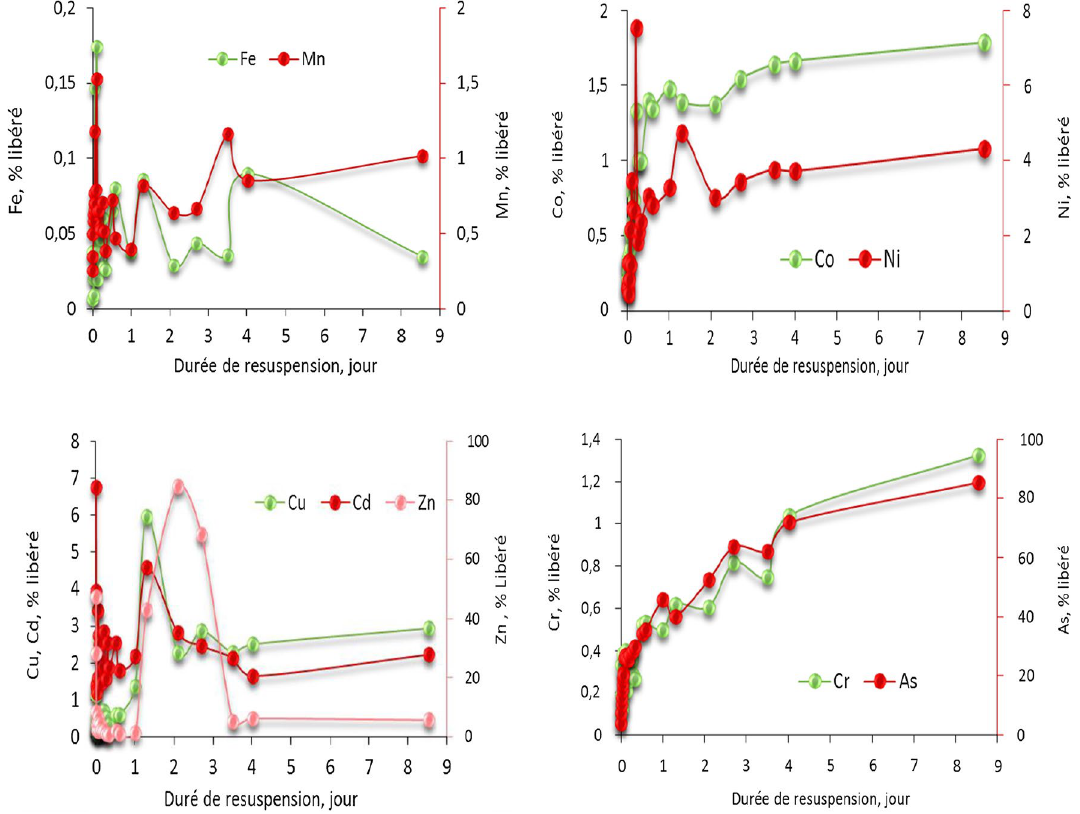
Fig. 3 Mobilization percentage EMT during the resuspension under continuous oxygen bubbling of fresh sediment of Sebou